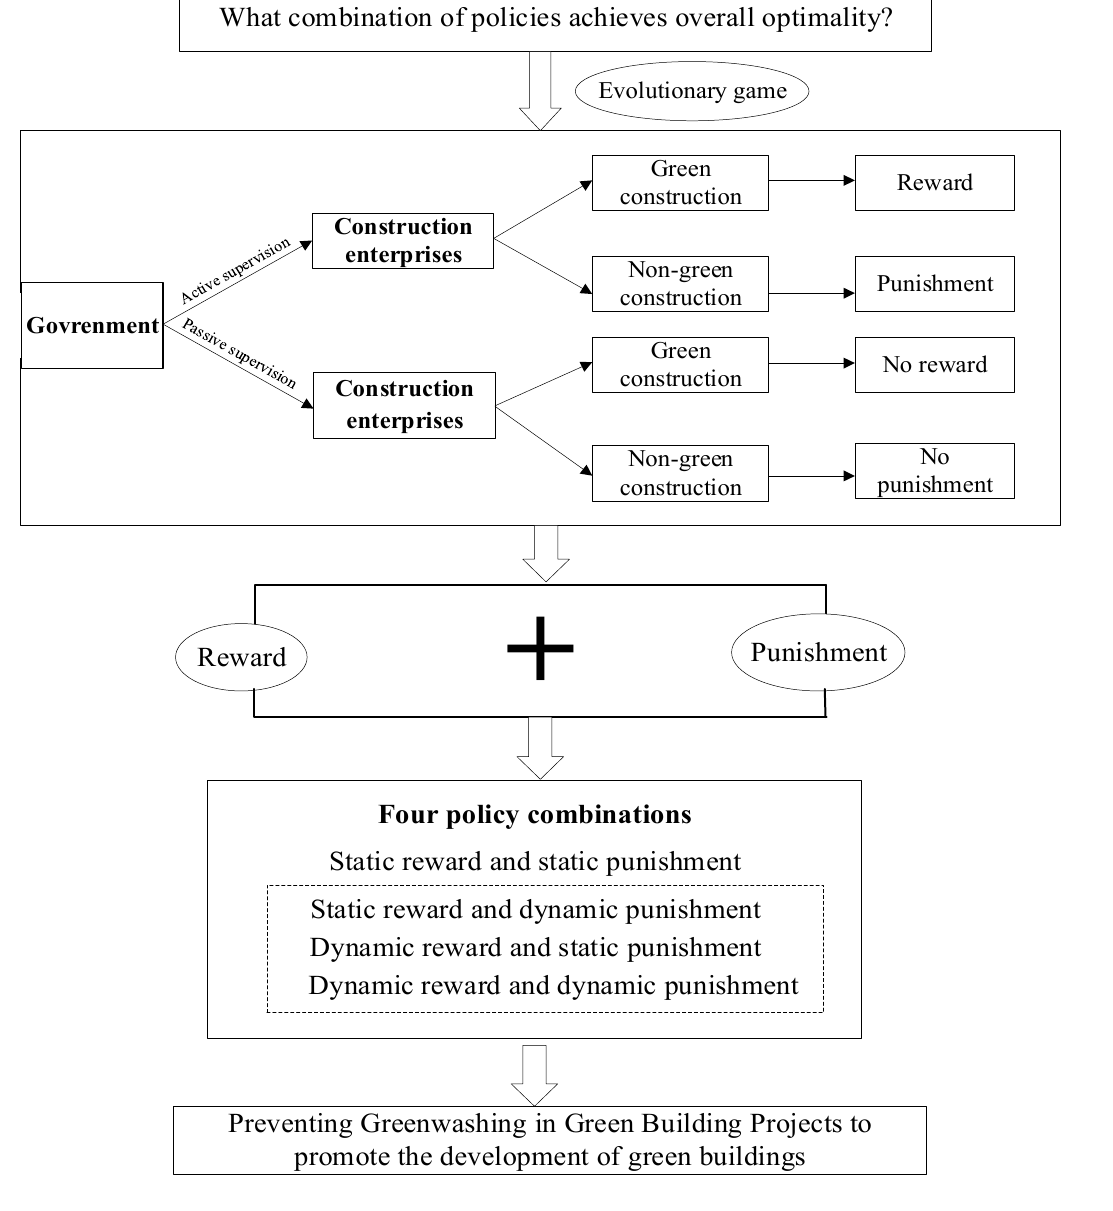
Figure 1. Research fl